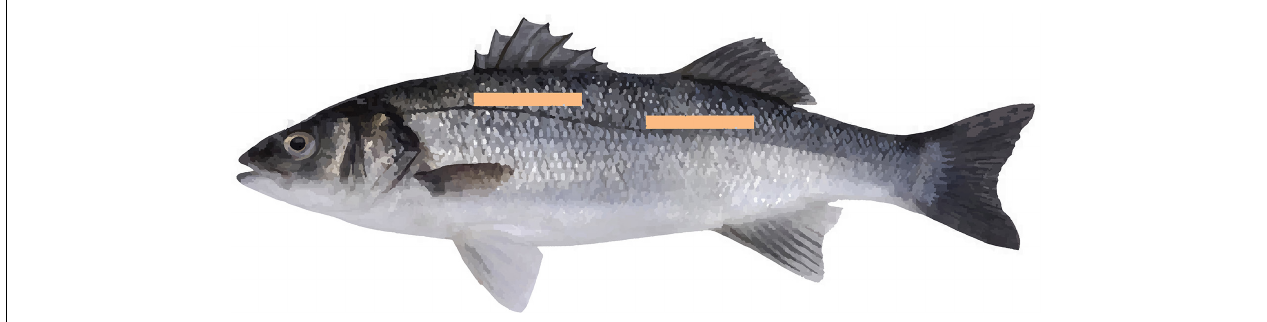
FIGURE 1 | Diagram of the two positions the handheld dielectric spectrometer was used to record fillet lipid percentage. Note, four measurements were taken per fish with the two additional measurements mirrored on the other side of the fish (not